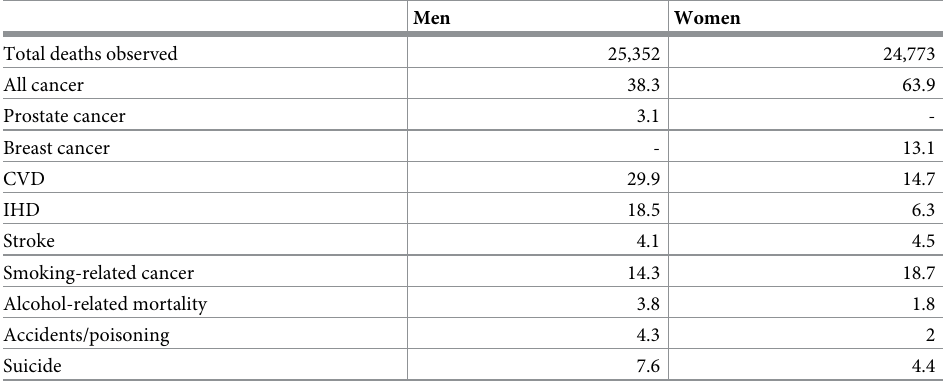
Table 1. Cause of death distribution across sample, % of all deaths for men and women separately.